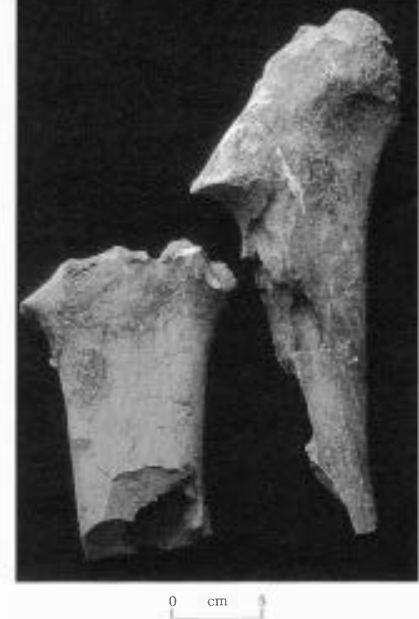
Figure 8 Cattle bones (a radius and an ulna of the forelimb) from the Kopal area at (:atalhOyiik; the radius (left) has prob­ ably been smashed to en abl e the ma r row to be